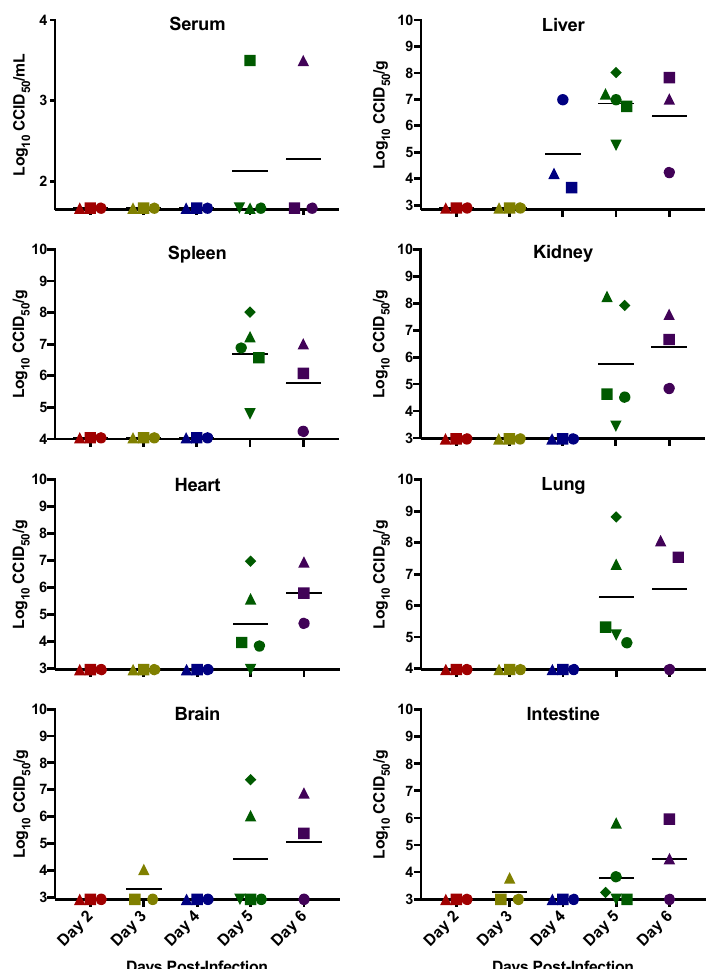
Figure 2. Infectious viral titers during RVFV MP-12 infection in STAT2 KO hamsters. Groups of hamsters ( n = 3–4) were sacrificed on the specified days post-infection for analysis of serum, liver, spleen, kidney, heart, lung, brain, and small intestine virus titers. One animal in the day 6 group succumbed to infection prior to the time of sacrifice and therefore its tissue titers (no serum could be obtained) are included in the day 5 cohort for this animal (green diamond). Unique symbols at each sacrifice day represent the same animals across all graphs.